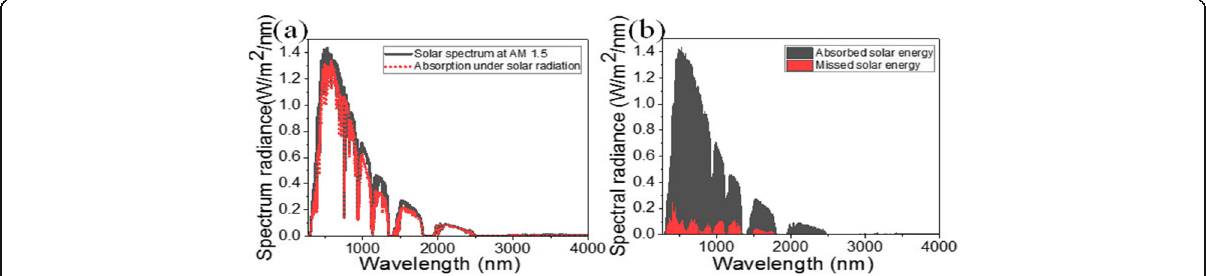
Fig. 4 a Standard spectrum of solar radiance AM 1.5 and solar energy absorption spectrum of the solar absorber under the AM 1.5. b Absorbed and missed energy of the solar absorber in the full spectral range of solar